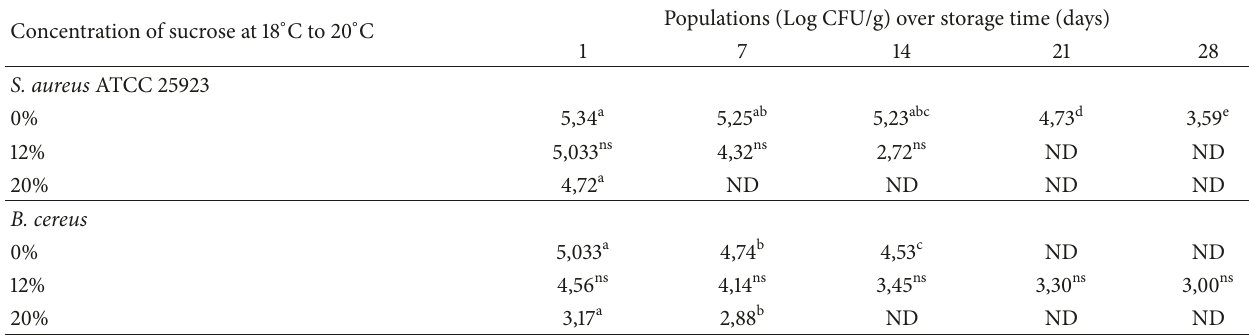
Table 3: Populations of S. aureus ATCC 25923 and B. cereus in almond butter at varying concentrations of sugar stored at 18 ∘ C. Concentration of sucrose at 18 ∘ C to 20 ∘ C